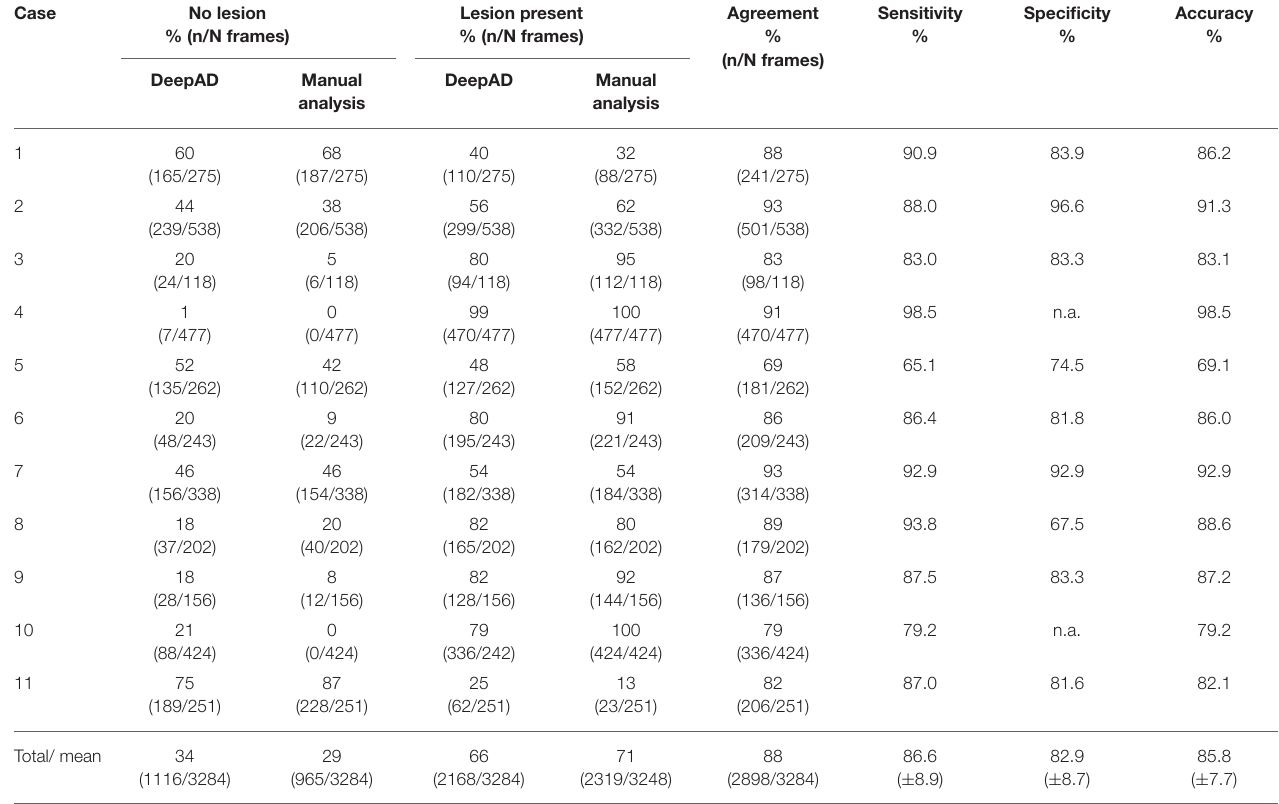
Agreement Sensitivity Specificity Accuracy % % % % (n/N frames)